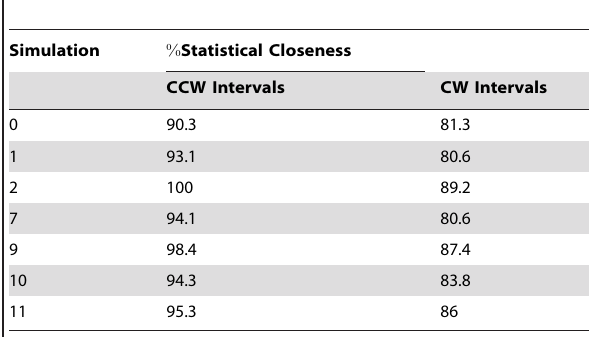
Table 3. Statistical closeness between the simulations and the experimental data.